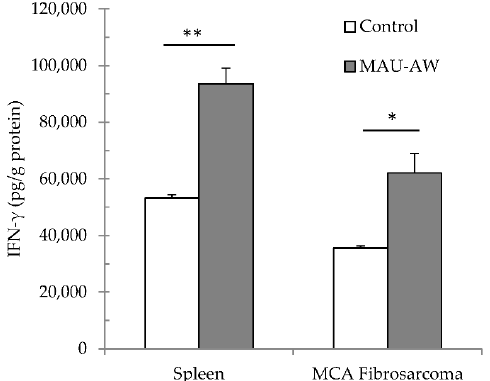
Figure 4. Cytokine modulation in spleen and MCA fibrosarcoma-bearing mice. Following three successive days of i.p. administration of MAU-AW (10 µ g) in tumor-bearing mice, spleen and MCA fibrosarcoma were isolated, and IFN- γ levels were assayed in these tissues. MAU-AW increased IFN- γ levels in MCA fibrosarcoma, as well as spleen. Each data point represents four mice ˘ SEM (* p < 0.05; ** p < 0.01 vs. control